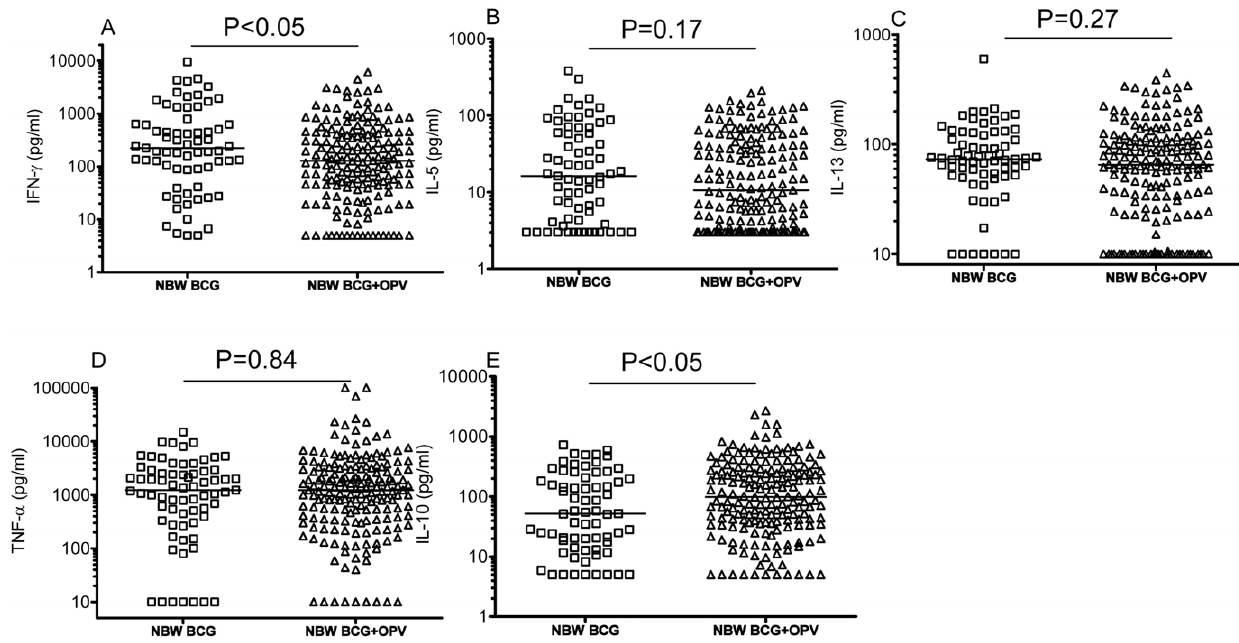
Figure 3. PPD stimulated IFN- c (A), IL-5 (B), IL-13 (C), TNF- a (D) and IL-10 (E) production in normal birth weight BCG (NBW BCG) and BCG + OPV vaccinated (NBW BCG + OPV) infants. One dot represents one individual. Horizontal lines represent medians.